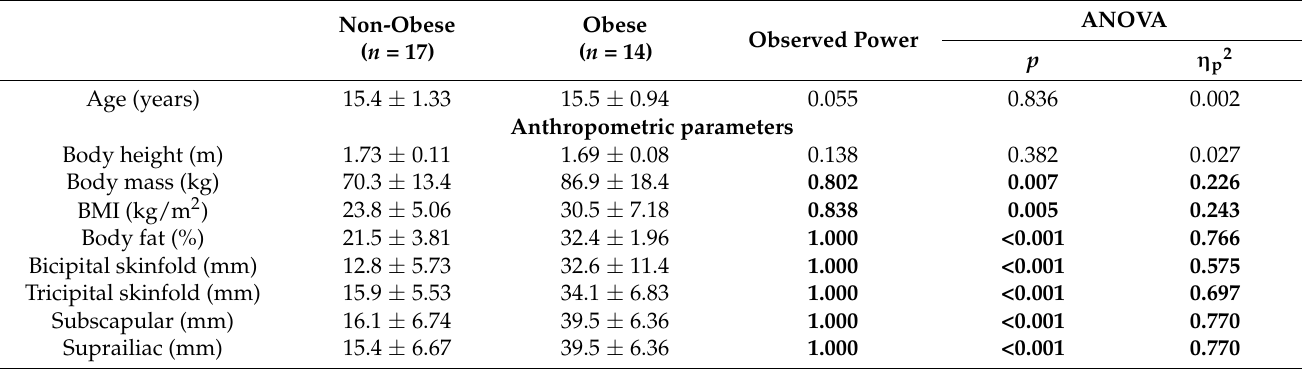
Table 2. Comparison of age and anthropometric parameters between two groups. Data are presented as mean ± standard deviation. Meaningful effects (criteria: p < 0.05 and η p2 > 0.15 and observed power >0.60) marked in bold.